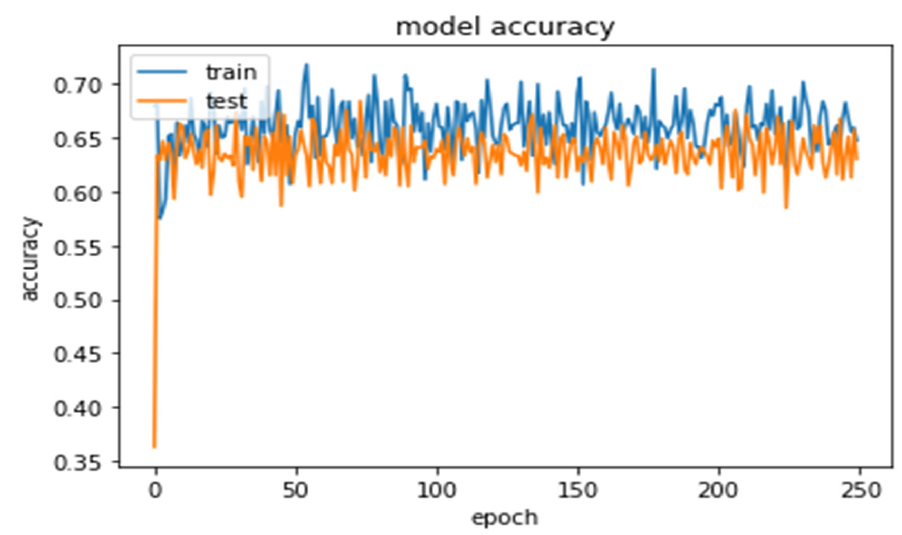
Figure 10. Model’s training and test accuracy with increased architecture.